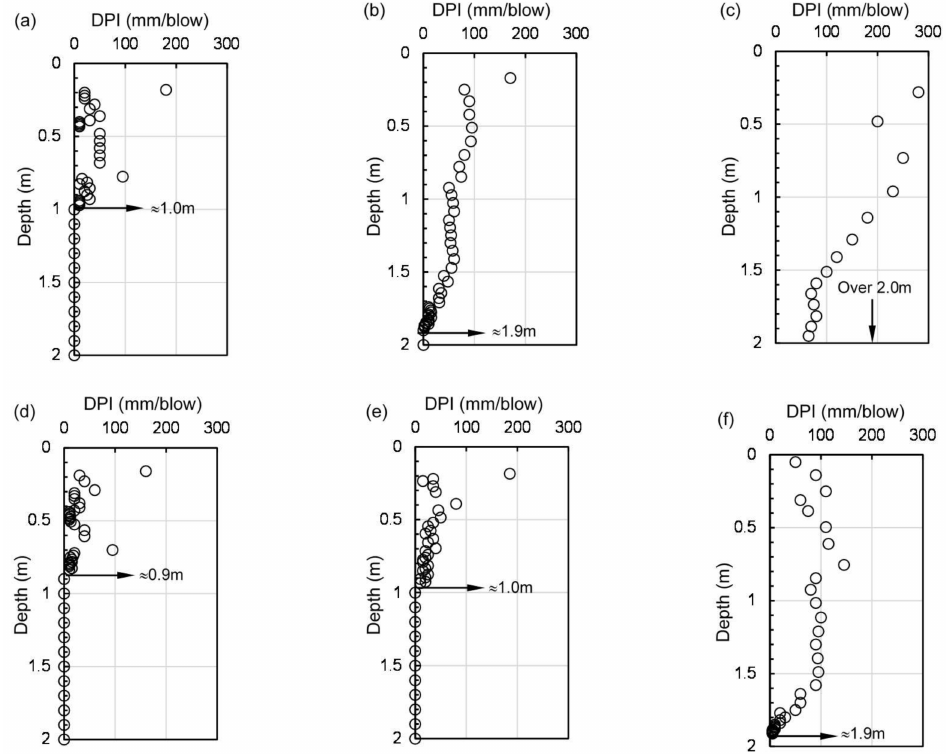
Figure 9. Soil depth based on dynamic cone penetration test: ( a ) 30 m of BTS; ( b ) 80 m of BTS; ( c ) 100 m of BTS; ( d ) 20 m of BS; ( e ) 30 m of MS; and ( f ) 20 m of